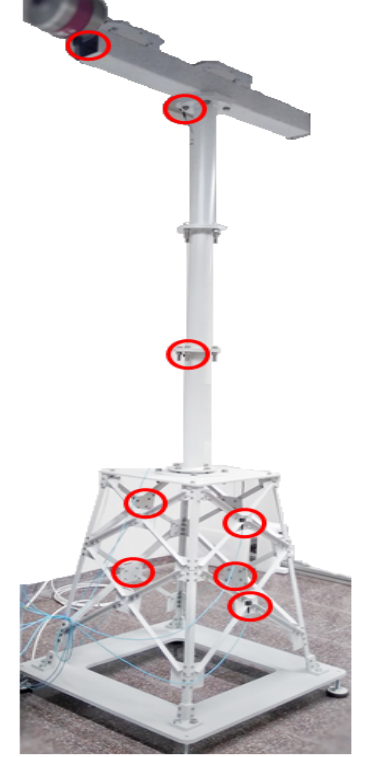
Figure 6. Location of the sensors on the overall structure.